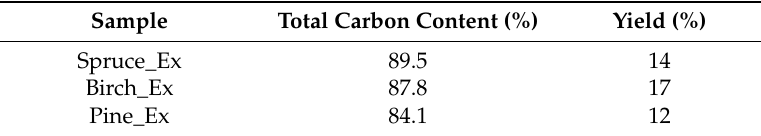
Table 5. Total carbon content and yield of extracted sawdust-based